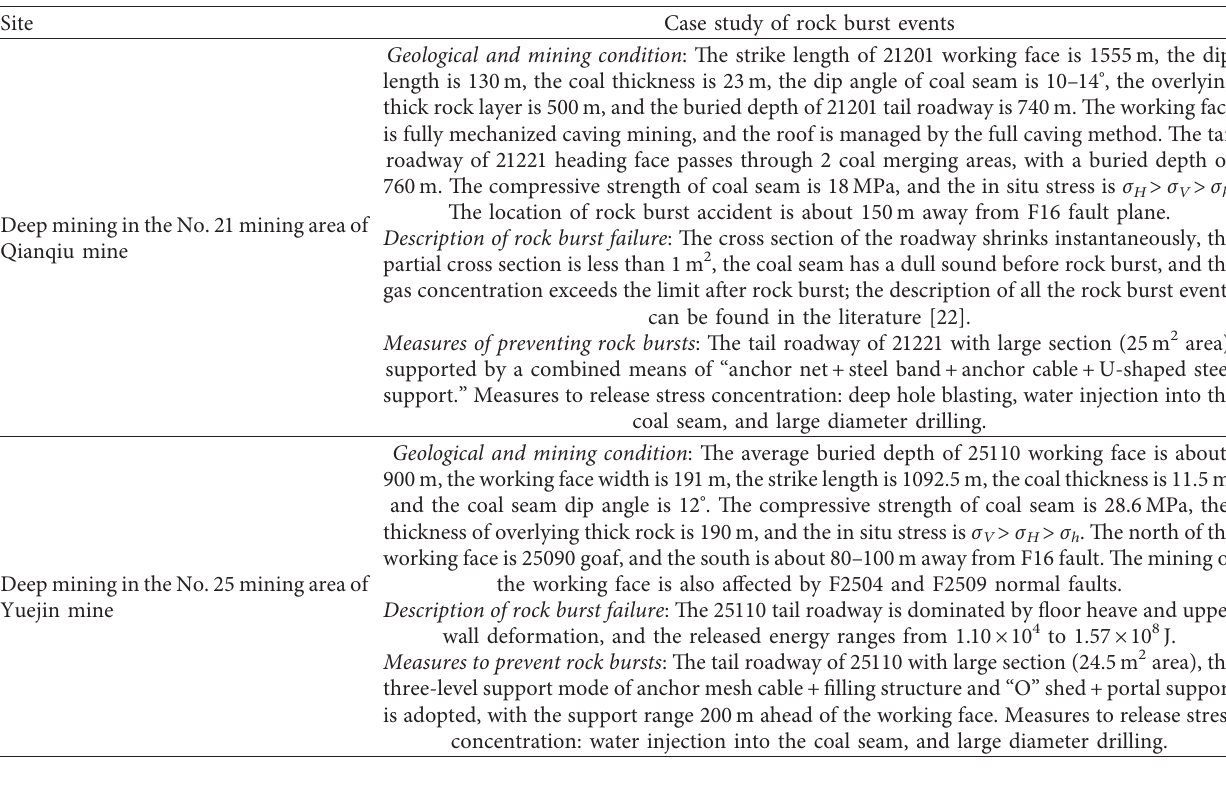
Table 2: Statistics of rock burst cases in deep mining near the fault.